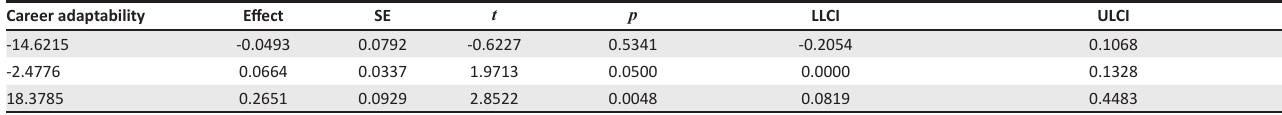
TABLE 6: Conditional effects of the focal predictor at values of the moderator(s)/Johnson–Neyman significance region(s). Career adaptability